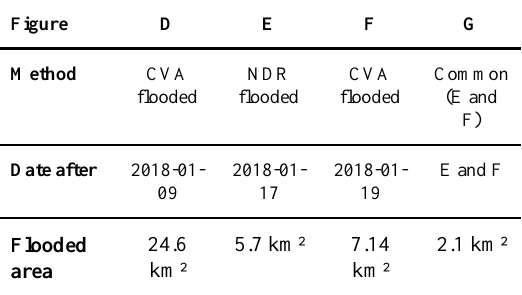
Table 2. Evolution of the flooded areas in the region of Miandrivazo (within a 100 km² square reference).